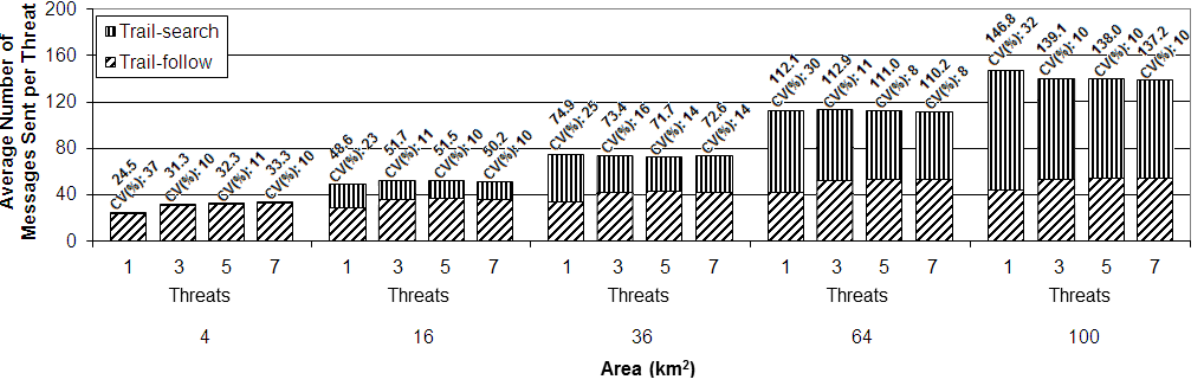
Figure 11. Results of the cost metric in terms of the average number of messages sent per threat for the simulations with one Unmanned Aerial Vehicle and the four different numbers of threats (1, 3, 5 and